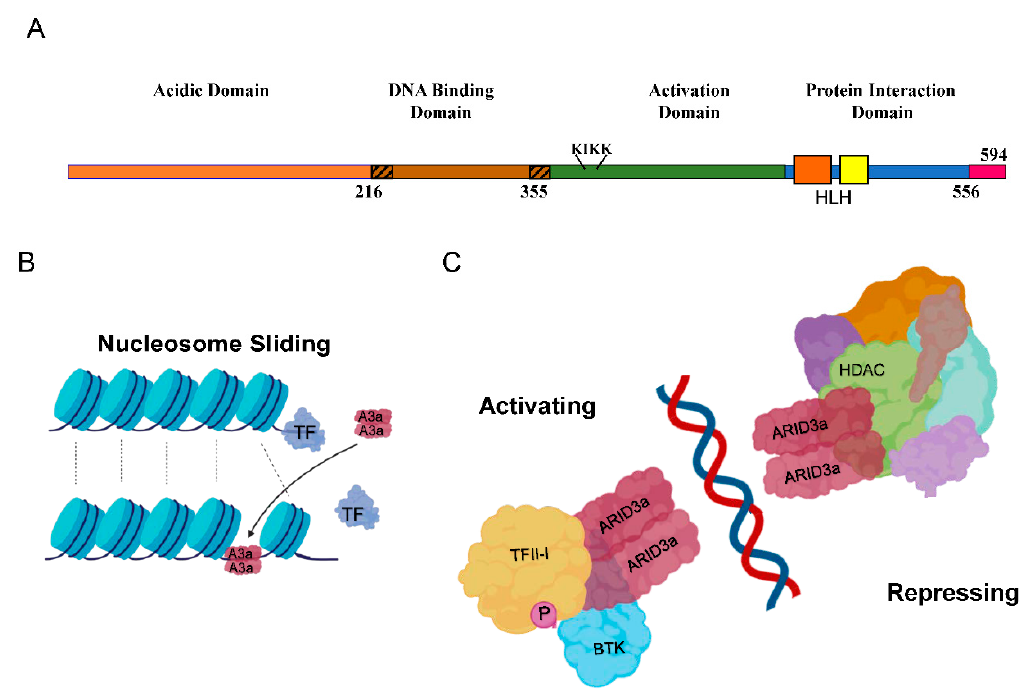
Figure 1. Schematic diagrams of ARID3a (A + T rich interaction domain protein 3a) domains and functions. ( A ) The four protein domains of ARID3a are shown, including the extended DNA-binding domain (hashed ends), the nuclear localization motif (KIKK), the helix-loop-helix regions (orange and yellow boxes), and amino acid numbers. The short carboxyl terminus has not been given a name or